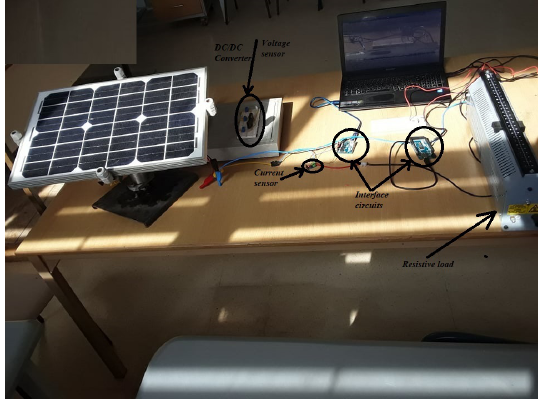
Figure 13. The proposed photovoltaic